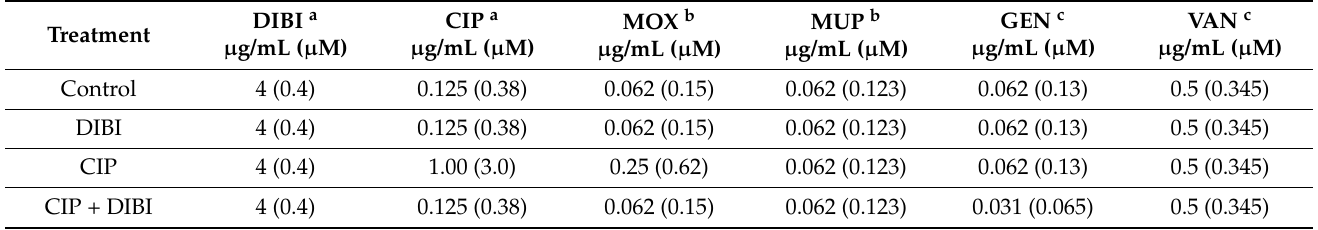
Table 4. Median 24 h MIC values for 96 h ciprofloxacin kill/growth Staphylococcus aureus survivor clones.